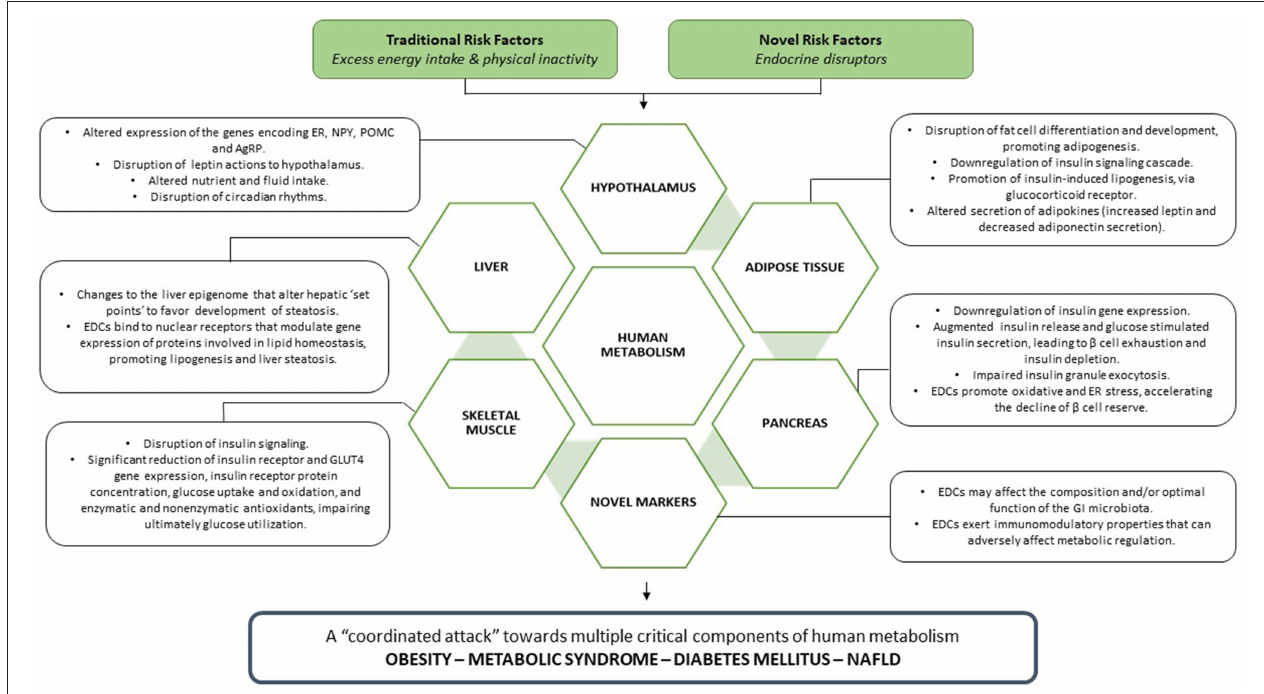
FIGURE 3 | EDCs, acting in parallel with traditional metabolic risk factors, unleash a coordinated attack toward every crucial component of human metabolism, leading ultimately to the manifestation of metabolic disease.